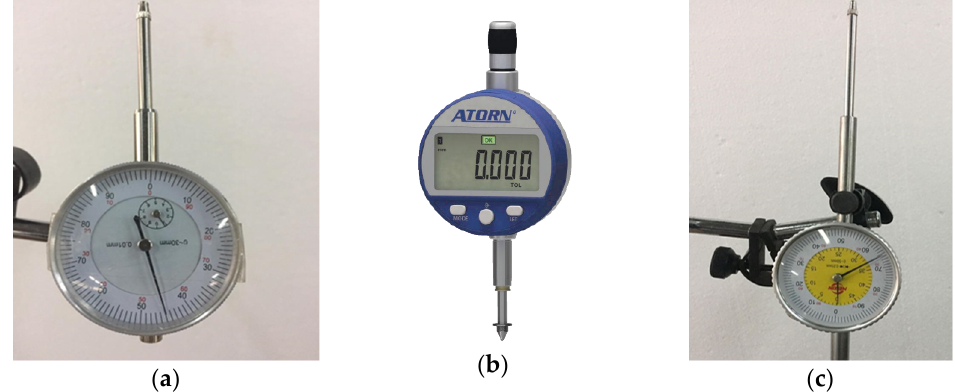
Figure 6. Dial gauges used in the present study. ( a ) Mechanical dial gauge. ( b ) Electronic dial gauge. ( c ) Mechanical dial gauge.